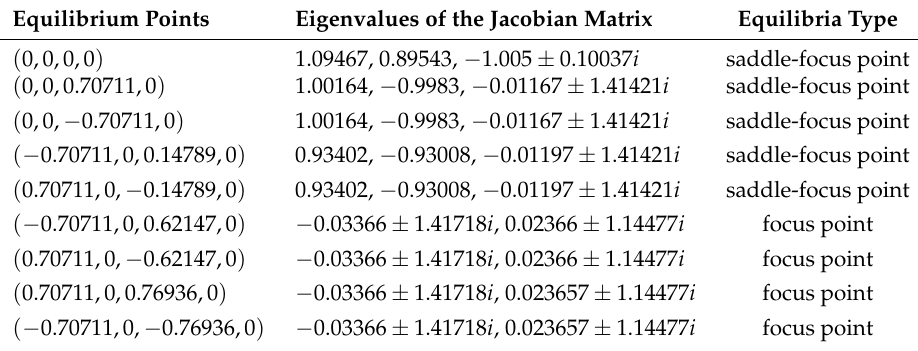
Table 1. The eigenvalues of the corresponding Jacobian matrix and the equilibria type. Equilibrium Points Eigenvalues of the Jacobian Matrix Equilibria Type